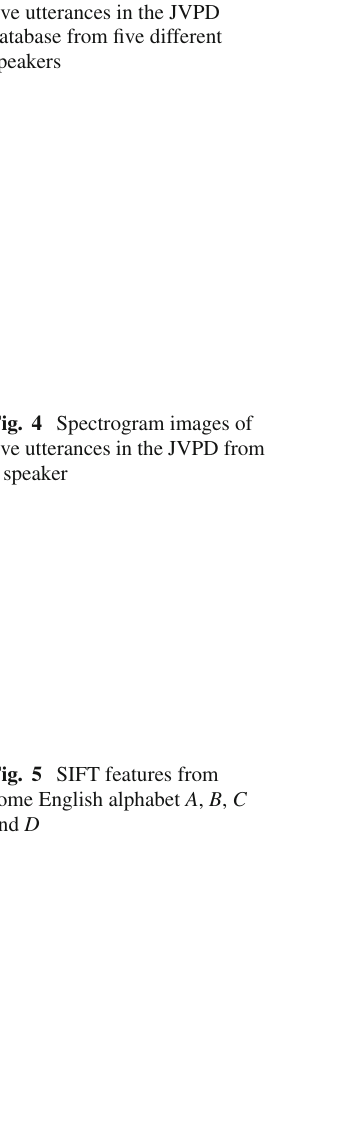
Fig. 3 Spectrogram images of five utterances in the JVPD database from five different speakers